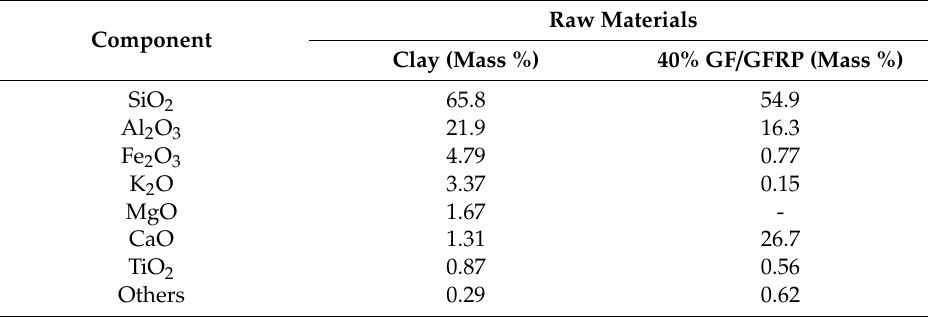
Table 1. Compositions of inorganic substances in the clay and GFRP.